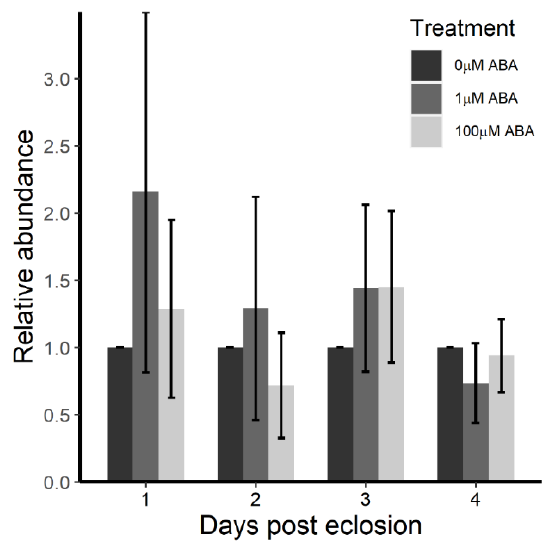
Figure 3. Content of the neutral lipid triacylglycerol (TAG) in sugar-fed, adult female A. stephensi derived from control and ABA-treated larvae did not di ff er through four days following eclosion. Relative to controls (0 µ M ABA), there were no di ff erences in TAG abundance in females derived from ABA-treated larvae at day 1 ( F = 1.931, p = 0.199), day 2 ( F = 2.420, p = 0.132), day 3 ( F = 1.416, p = 0.269) or day 4 ( F = 2.440, p = 0.139). Data were analyzed by ANOVA and are shown as mean ± SE across 4–5 biological replicates with separate cohorts of A. stephensi